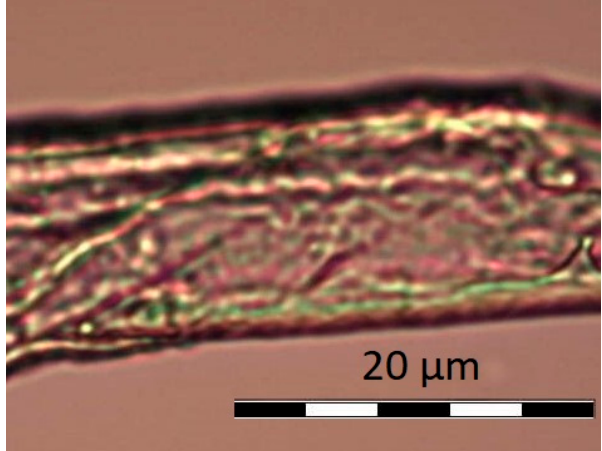
Figure 3. Obtained results for measurements of PDI of samples, n = 5, the Y-bars represent the standard deviation.